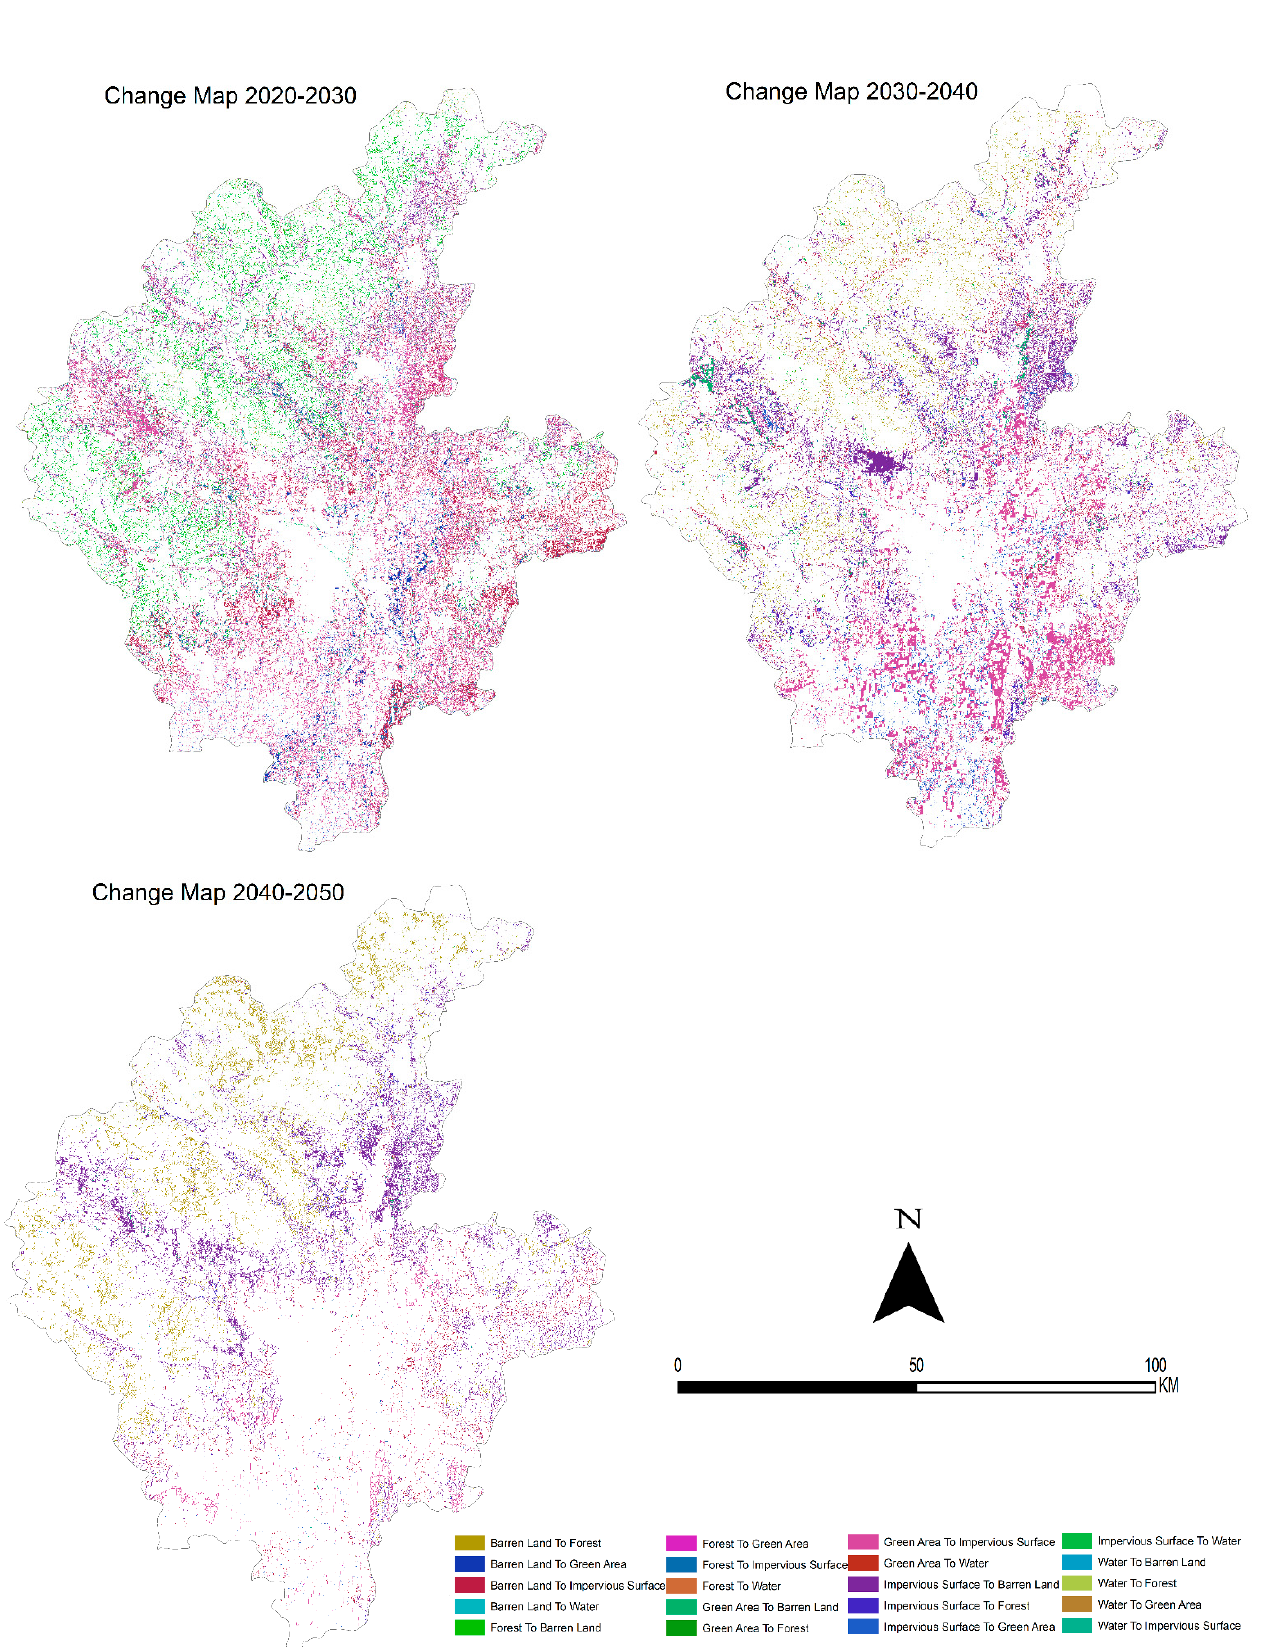
Figure 11. Linyi change maps 2030–2050.